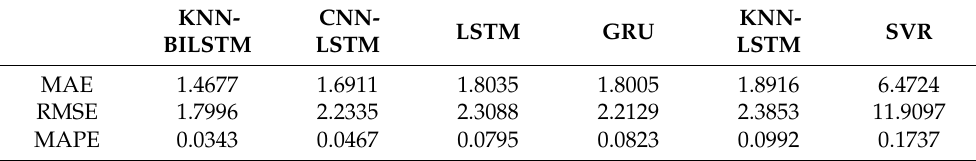
Table 3. Error table of prediction results of the different